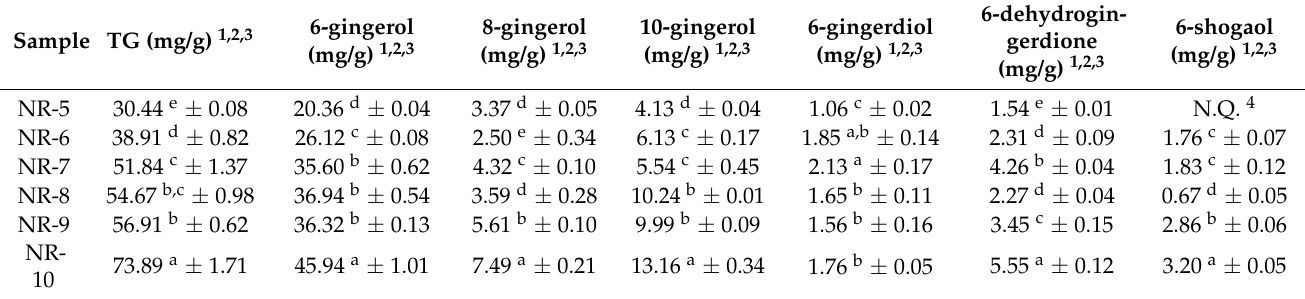
Table 6. Phenolic content of Z. officinale rhizomes from experimental